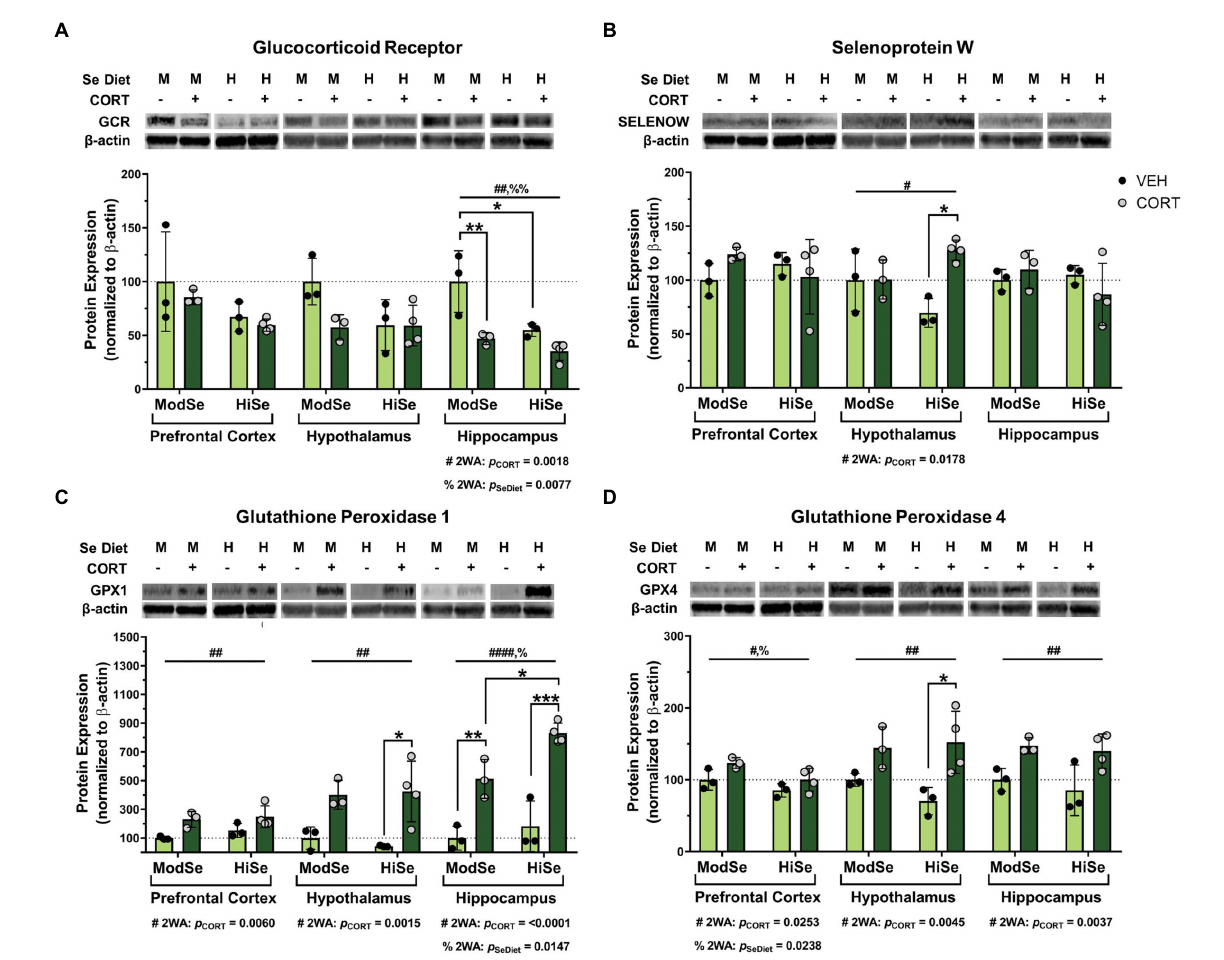
FIGURE 2 Western blot analysis of the prefrontal cortex (PFC), hypothalamus (HYP), and hippocampus (HPC) of male mice on either a moderate (ModSe) or high selenium (HiSe) diet being treated with either CORT or vehicle control (VEH). (A) Percentage change in glucocorticoid receptor (GCR) protein levels. HPC: CORT and HiSe consumption both independently decreased GCR levels [p CORT = 0.0018, F (1,9) = 15.15. p SeDiet = 0.0077, F (1,9) = 11.68]. HiSe diet without CORT decreased GCR to the level of CORT-exposed ModSe mice, and GCR expression in both groups was significantly lower than the ModSe/VEH group (B) Percentage change in SELENOW protein levels. HYP: CORT increased SELENOW levels [p CORT = 0.0178, F (1,9) = 8.378], particularly within HiSe offspring. (C) Percentage change in GPX1 protein levels. CORT significantly increased GPX1 levels in the PFC [p CORT = 0.0060, F (1,9) = 12.79], HYP [p CORT = 0.0015, F (1,9) = 20.28] and HPC [p CORT = <0.0001, F (1,9) = 63.59]. HiSe diet consumption increased GPX1 in the HPC: p SeDiet = 0.0147, F (1,9) = 9.052. GPX1 reached the highest levels within the HiSe/CORT condition as this group was significantly higher than the ModSe/CORT group. (D) Percentage change in GPX4 protein levels. GPX4 was elevated in response to CORT in all brain regions: PFC [p CORT = 0.0238, F (1,9) = 7.372], HYP [p CORT = 0.0045, F (1,9) = 14.08], and HPC [p CORT = 0.0037, F (1,9) = 15.15]. Unexpectedly, maternal Se intake negatively impacted GPX4 levels in the PFC: p SeDiet = 0.0253, F (1,9) = 7.171. Individual data points are shown and bars indicate the mean ± standard error of the mean. All comparisons were made within each brain region for each protein via 2-way ANOVA, where # indicates a significant effect of CORT and % a significant effect of Se diet, with Tukey’s multiple comparisons used as